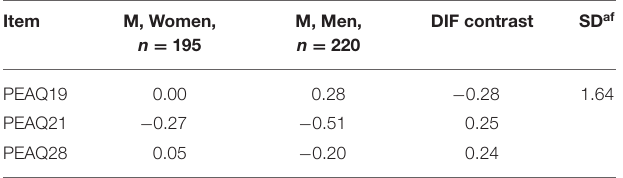
TABLE 3 | Mantel Haenszel statistics ( p < 0.05) of the PEAQ items with the gender bias variable ( N = 415).